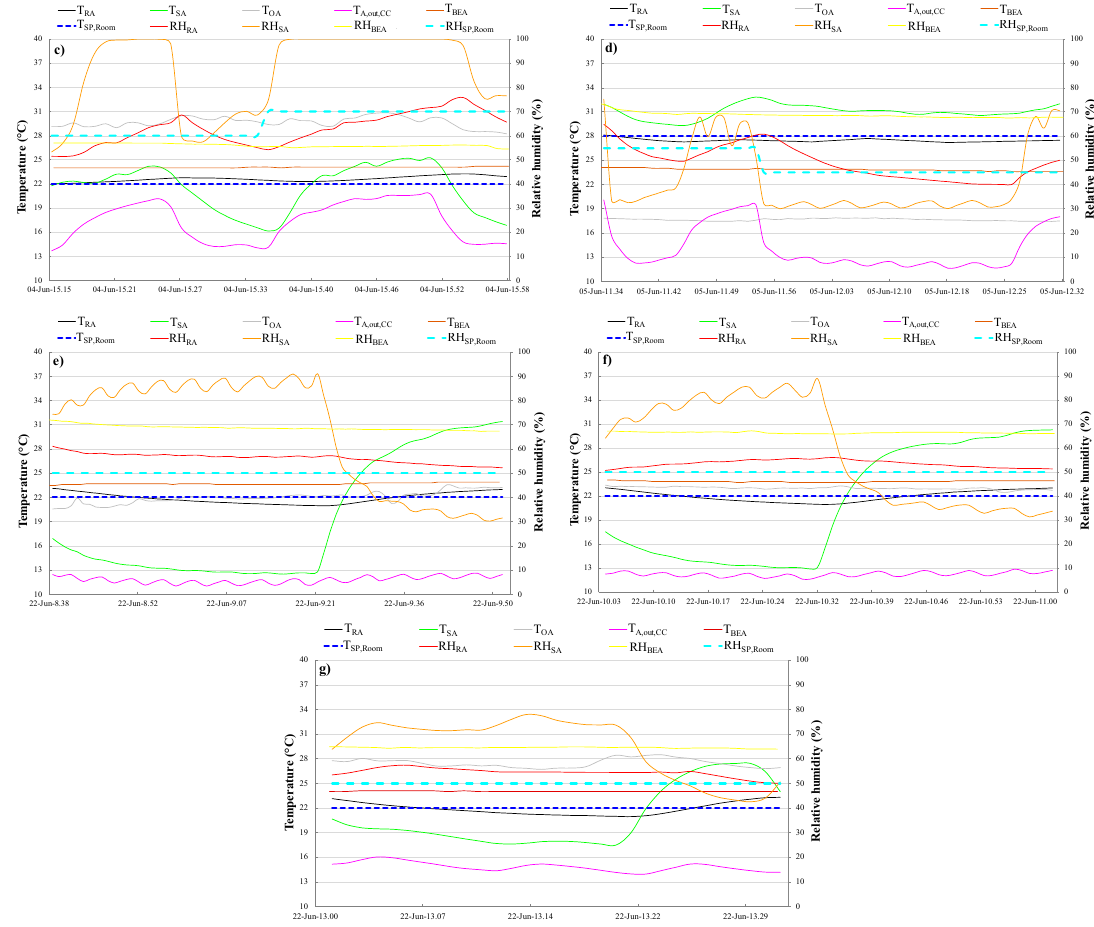
Figure 4. Experimental data measured during the test 1 ( a ), test 2 ( b ), test 3 ( c ), test 4 ( d ), test 5 ( e ), test 6 ( f ) and test 7 ( g ).